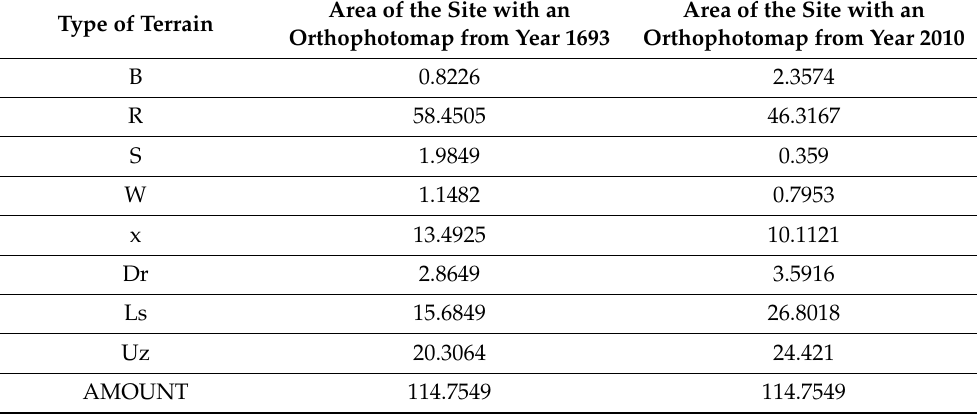
Table 3. The list of different use areas from 1963 and 2010.